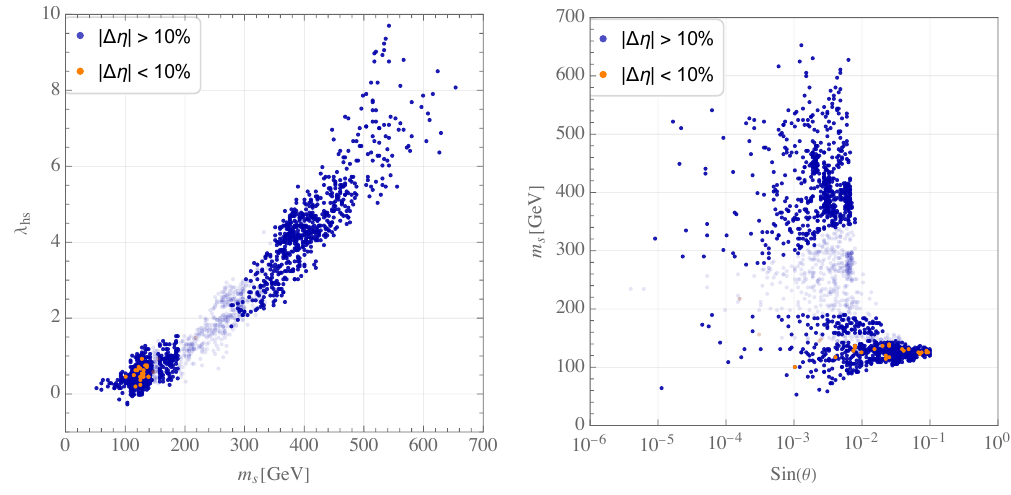
Figure 14 . Allowed parameter space of the CP-violating singlet model in the ( m s , λ hs ) plane (left panel) and the (sin θ, m s ) plane (right panel). The orange points predict a baryon asymmetry that lies within 10% deviation of the cosmological value, and hence delimit the preferred